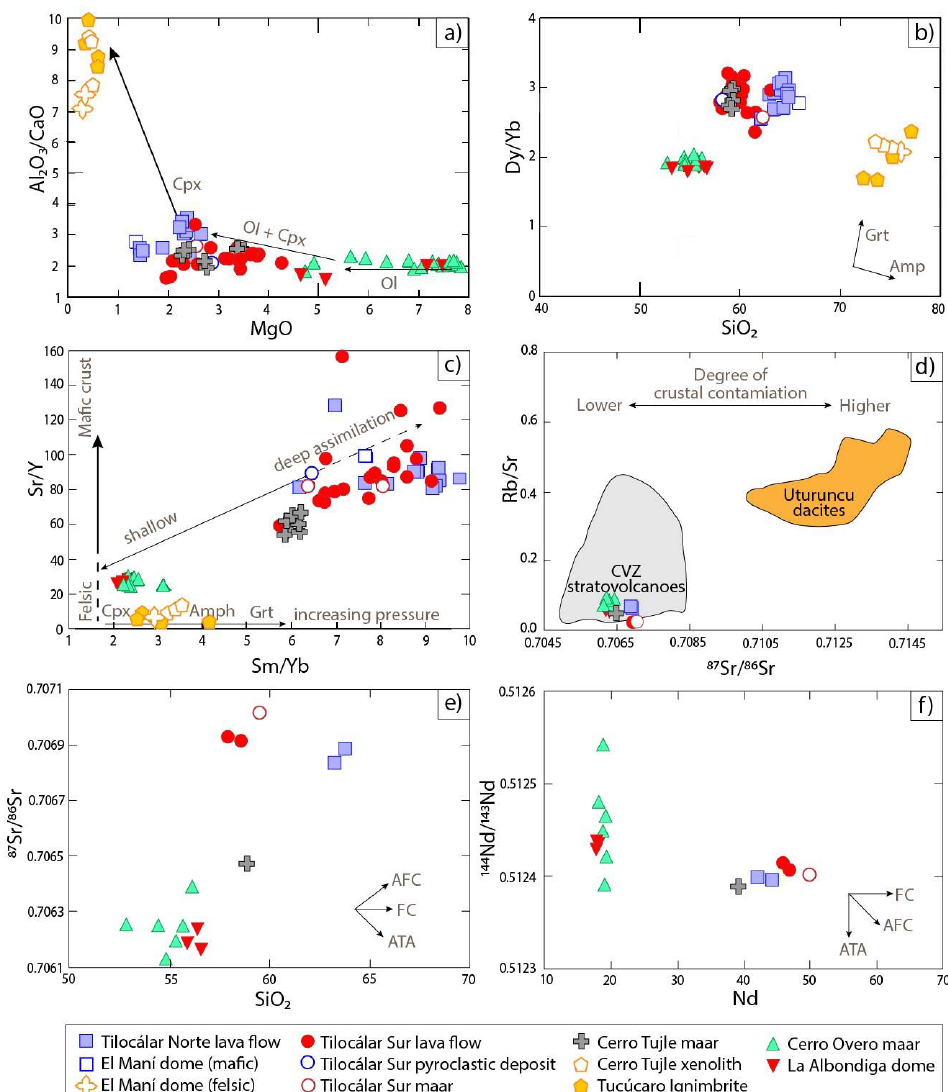
Figure 9. Diagrams showing ( a ) MgO (wt.%) vs. Al 2 O 3 /CaO, ( b ) Dy/Yb ratios vs. SiO 2 (wt.%), ( c ) Sm/Yb vs. Sr/Y ratios, ( d ) 87 Sr/ 86 Sr vs. Rb/Sr ratios, ( e ) 87 Sr/ 86 Sr vs. SiO 2 (wt.%), ( f ) 143 Nd/ 144 Nd vs. Nd (ppm). Data taken from Ureta, et al. [53], Ureta, et al. [50], and Ureta, et al. [54]. Arrows of differentiation trends after Mamani, et al. [66]. The diagram in ( d ) was modified from Taussi, et al. [138]. The values of both Rb/Sr and 87 Sr/ 86 Sr increase with an increasing degree of interaction with the partially molten Altiplano-Puna Magma Body. Grey and orange fields represent the Central Volcanic Zone (CVZ) of the Andes stratovolcano values from Mamani, et al. [66] and Uturruncu dacites from Michelfelder, et al. [139], respectively.